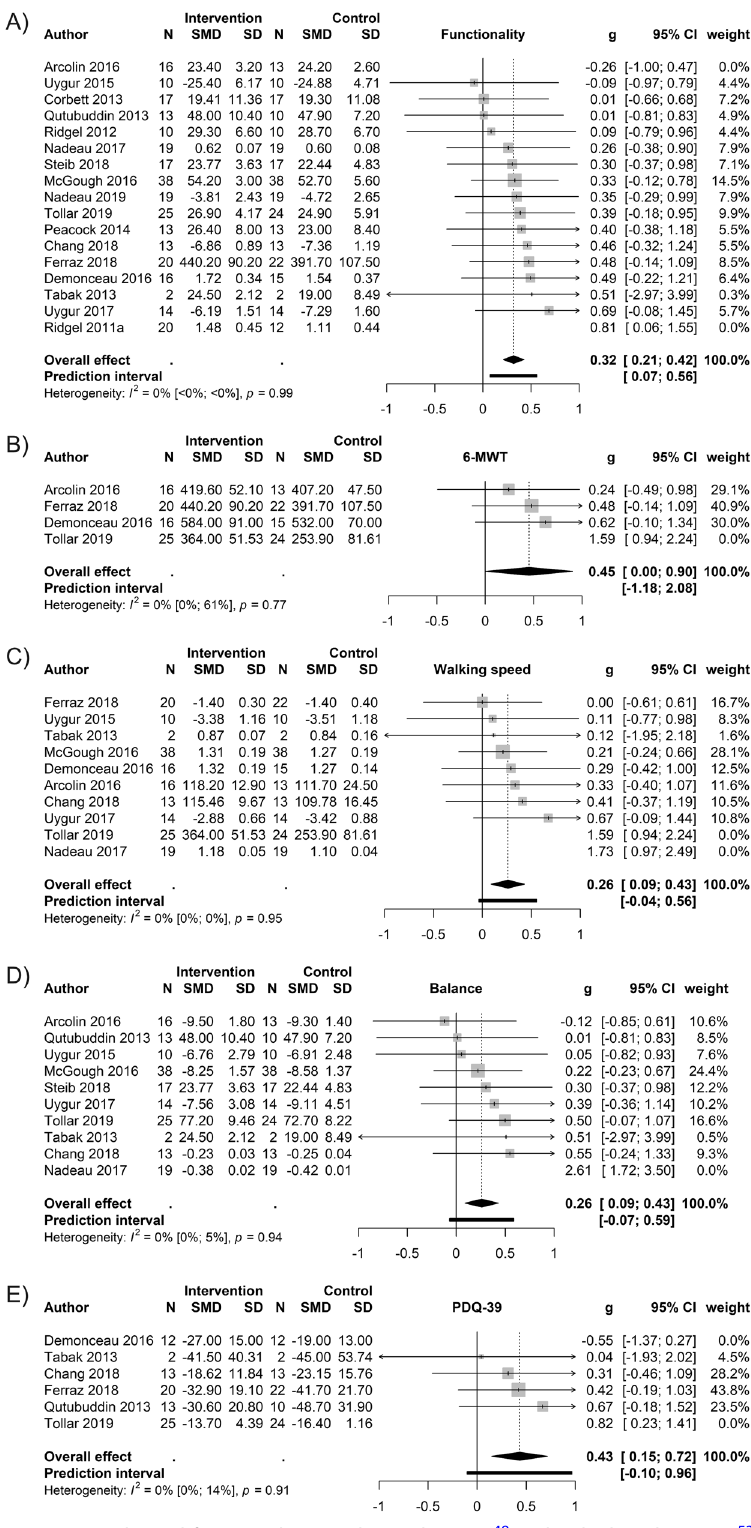
Fig. 4 Secondary outcome measures. A Physical functionality. Arcolin et al. (2016) 48 and Ridgel et al. (2011a) 53 were removed based on the in fl uence analysis. B Gait – 6-MWT. Tollár et al. (2019) 35 was removed based on the in fl uence analysis. C Gait – Speed. Tollár et al. (2019) 35 and Nadeau et al. (2017) 33 were removed based on the in fl uence analysis. D Balance. Nadeau et al. (2017) 33 was removed based on the CI-based outlier detection. E PDQ-39. Demonceau et al. (2017) 49 and Tollár et al. (2019) 35 were removed based on the in fl uence analysis. Panels A – E enlist the forest plots of the secondary outcome measures indicating signi fi cant improvements as a result of bicycling. All plots demonstrate the results after removing possible outlier studies.